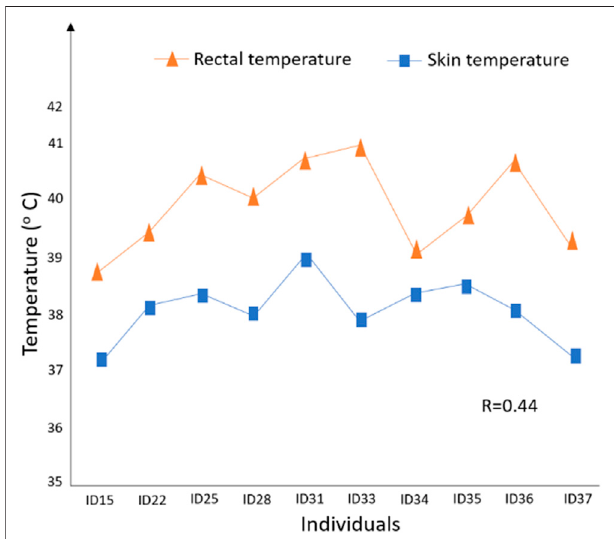
FIGURE8| Skinandrectaltemperaturemeasuresfor10Holsteincalves and correlation (R = 0.44) after heat stress (19:02 h); adapted from Srikanth et al.